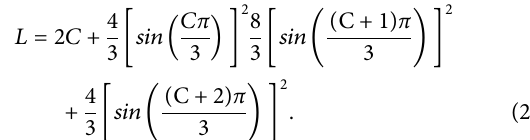
TABLE 2 | Haze level with attenuation [34].